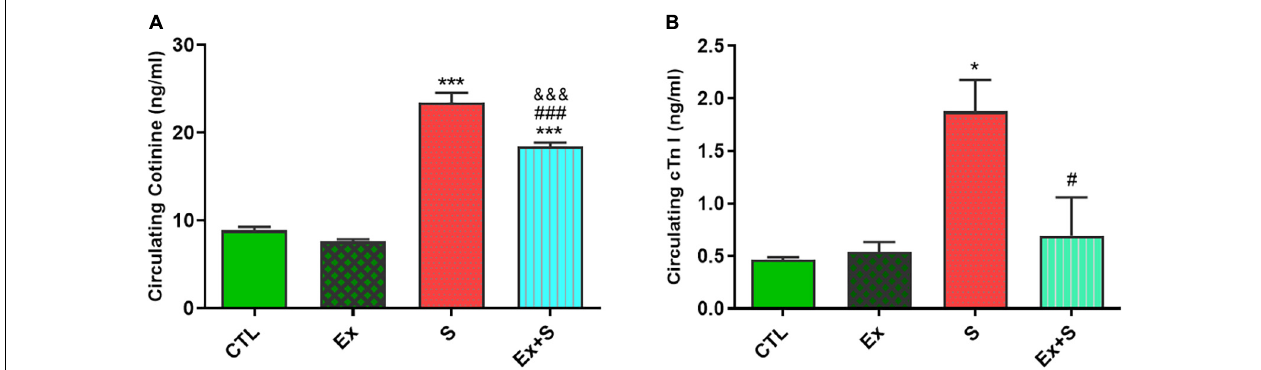
FIGURE 1 | Effects of waterpipe smoke inhalation on serum cardiac troponin I (A) and cotinine levels (B) in experimental groups. CTL, control group; Ex, group subjected to exercise training for 8 weeks; S, group subjected to waterpipe tobacco smoke inhalation for 8 weeks; Ex + S, group subjected to exercise training and waterpipe tobacco smoke inhalation for 8 weeks. The results are presented as mean ± SEM, n = 7.* P < 0.05; *** P < 0.001 vs. CTL; # P < 0.05, ### P < 0.001 vs. S; &&& P < 0.001 vs. Ex.